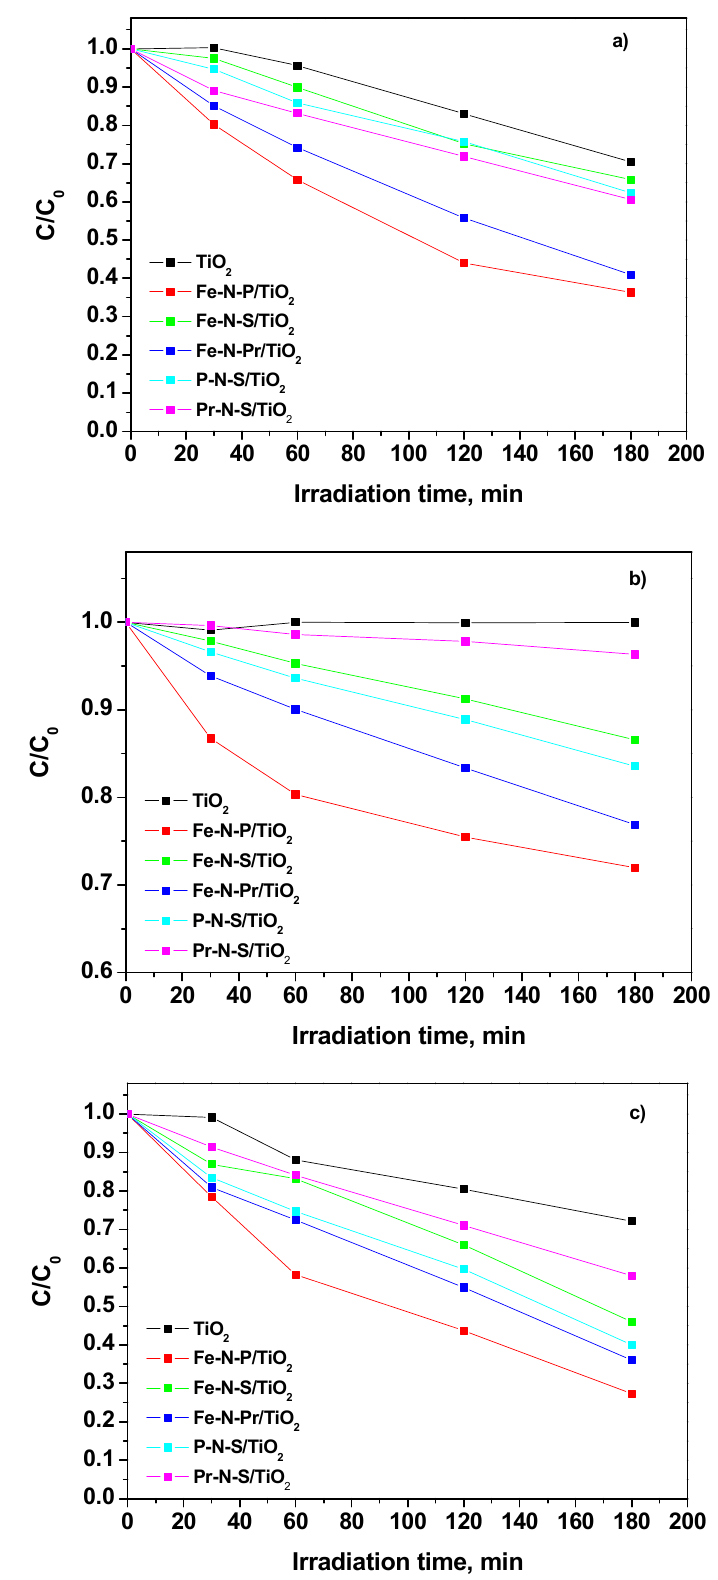
Figure 6. Photocatalytic degradation of THI under ( a ) UV-A, ( b ) visible, and ( c ) direct solar light irradiation.